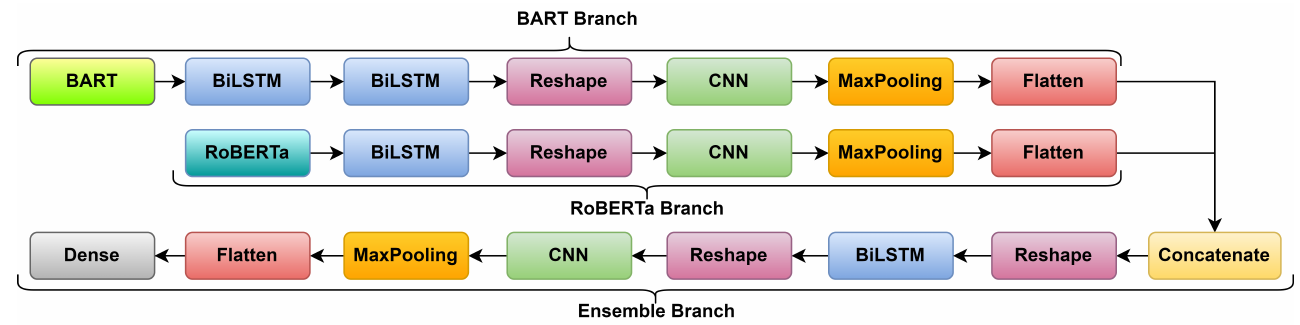
Figure 1. MisRoBÆRTa